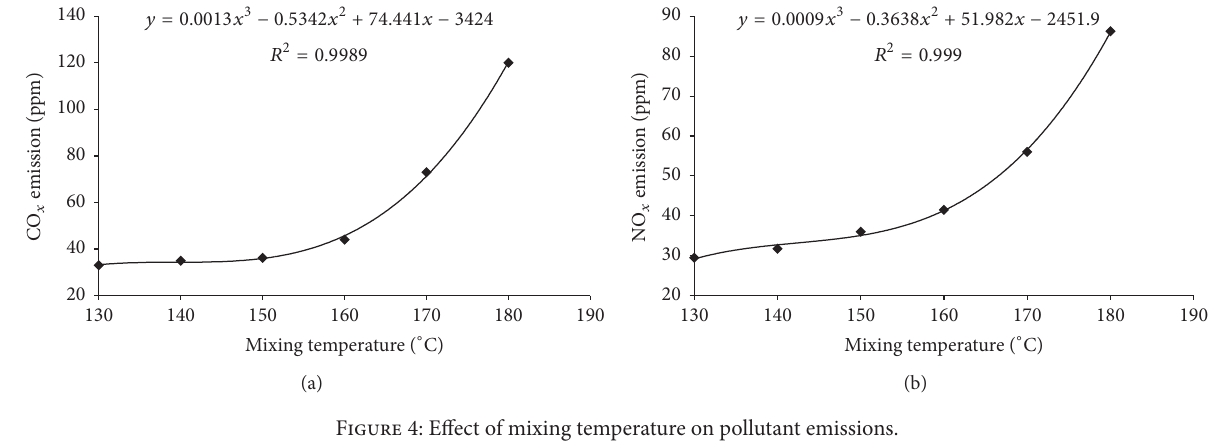
Figure 4: Effect of mixing temperature on pollutant emissions.